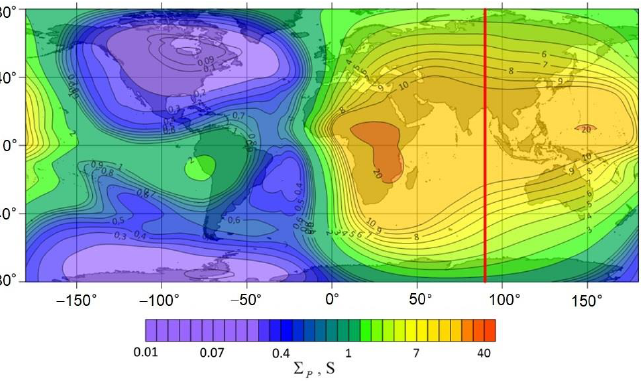
Figure 10. Pedersen background conductivity. The red vertical line shows the position of the subso- lar meridian.